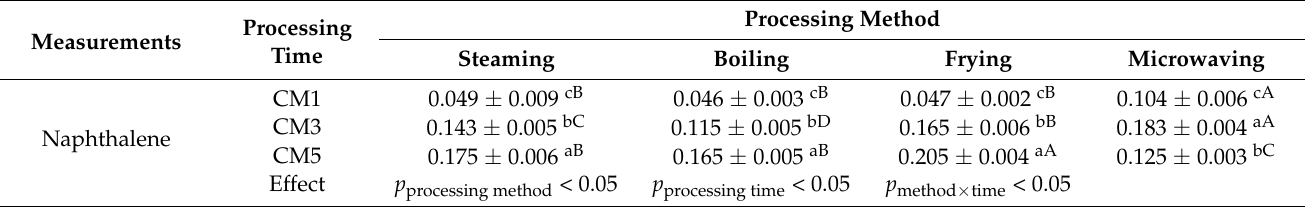
Table 5. Comparison of polycyclic aromatic hydrocarbons (mg/kg) in camel meat after different heat processing